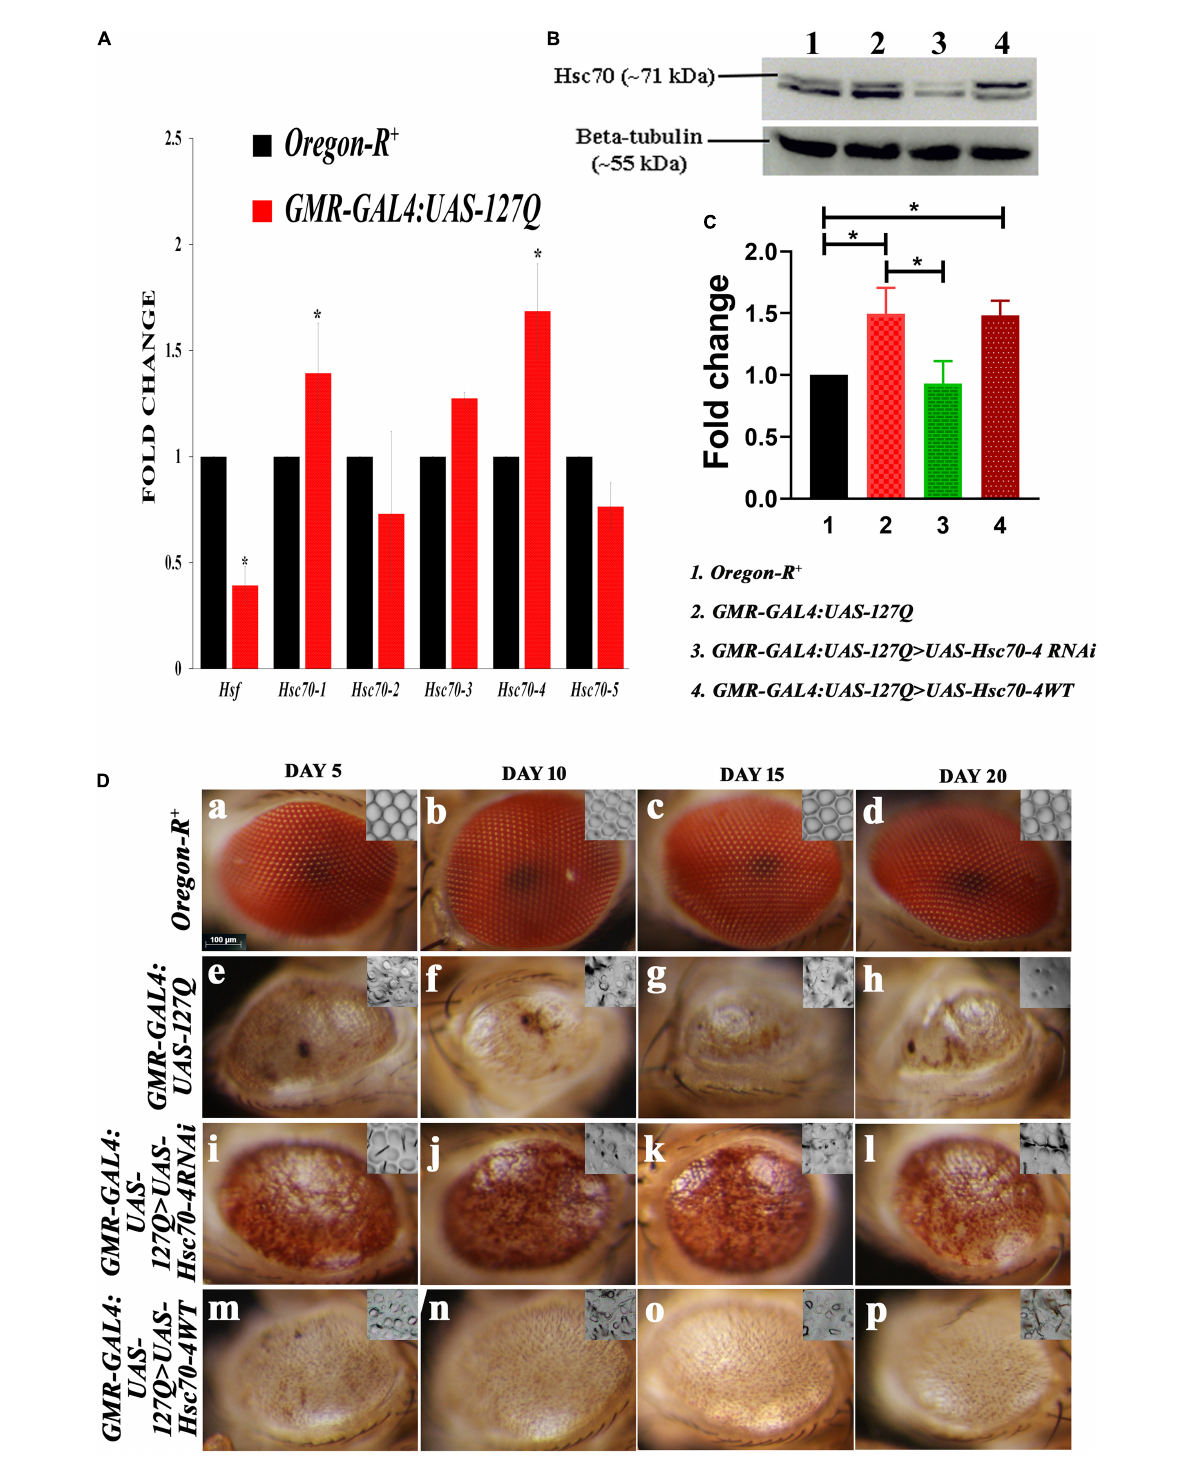
FIGURE1 Alterations in the hsc70 gene isoforms in the polyQ -overexpressing eye phenotype. (A) Transcript expressions of hsc70-1, hsc70-3, and hsc70-4 are upregulated compared to hsc70-2 and hsc70-5 , while that of hsf is reduced in GMR-GAL4:UAS-127Q in comparison to Oregon-R + (normalization is done using rp49 ). (B) Western blot showing the expression of Hsc70 in different genotypes. (C) Graph shows quantitative analysis of Hsc70 expression normalized to beta-tubulin, showing significant upregulation of the protein in lane 2 and 4 compared to lane 1. In contrast, the protein level of Hsc70 in the lane 3 was comparable to lane 1. However, it was significantly downregulated compared